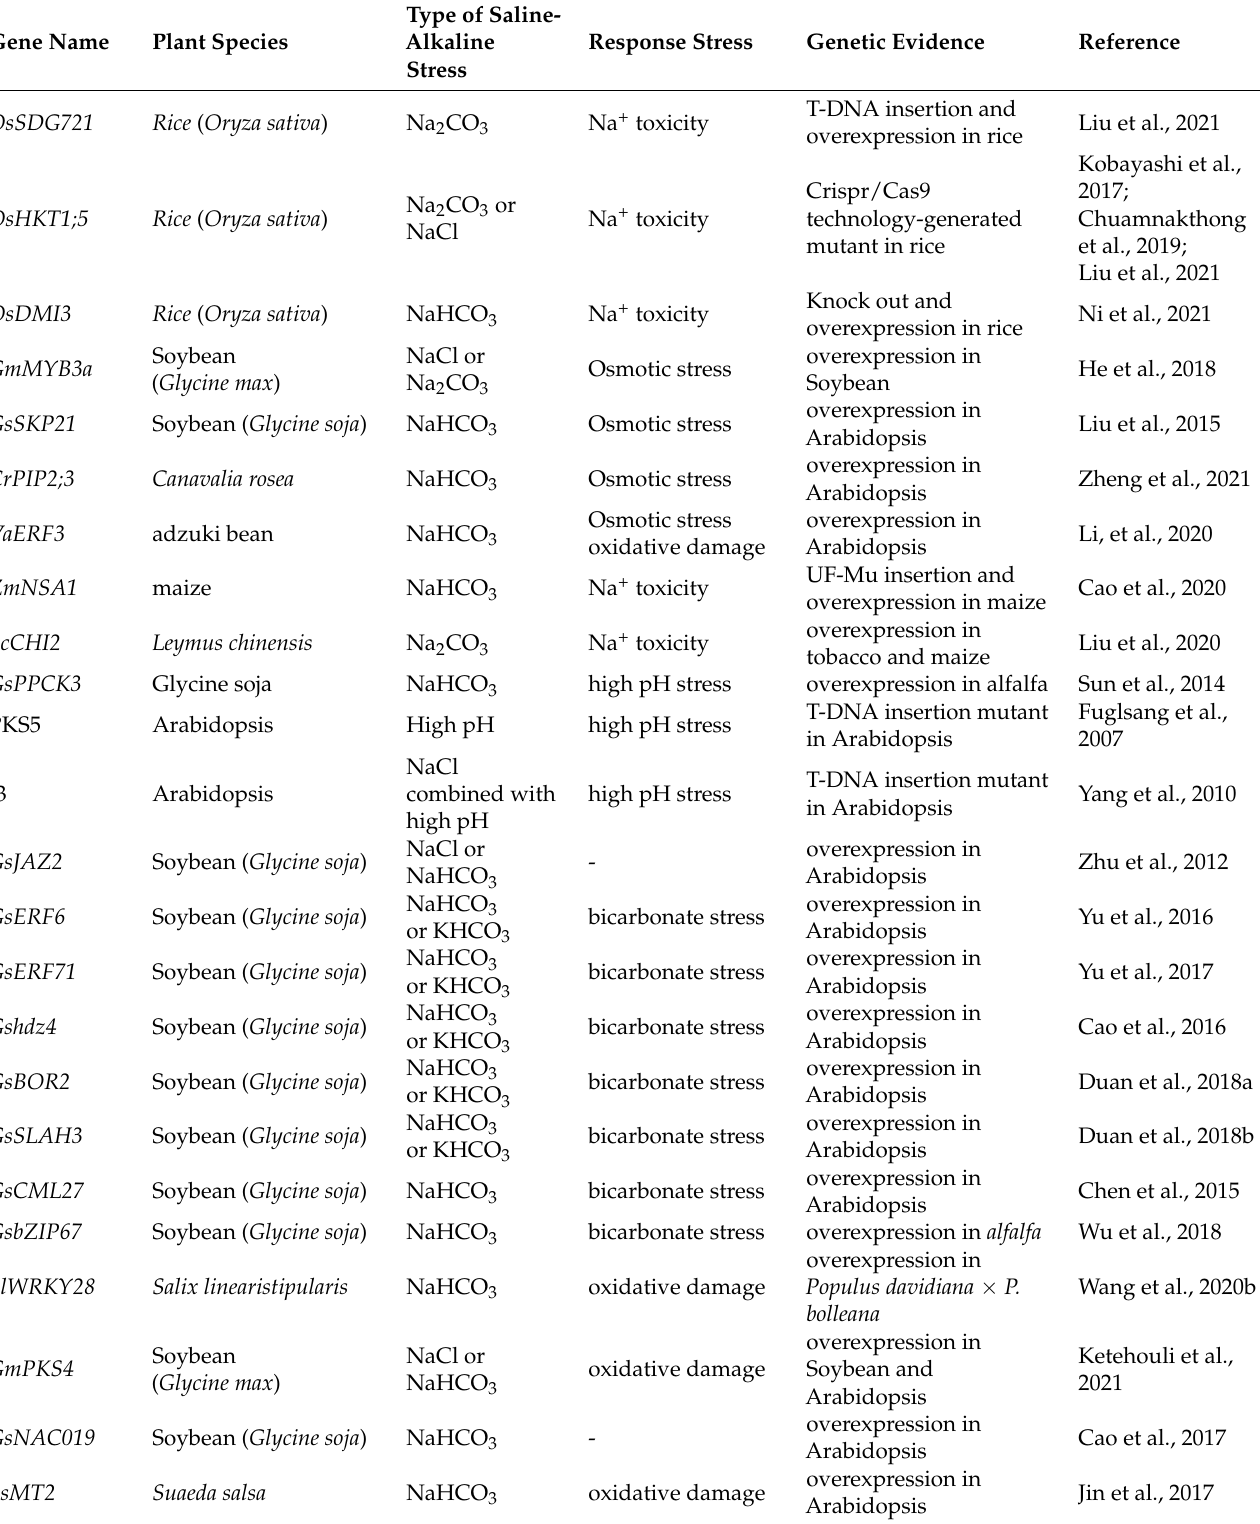
Table 1. List of genes likely associated with saline-alkaline (NaHCO 3 and Na 2 CO 3 ) tolerance in